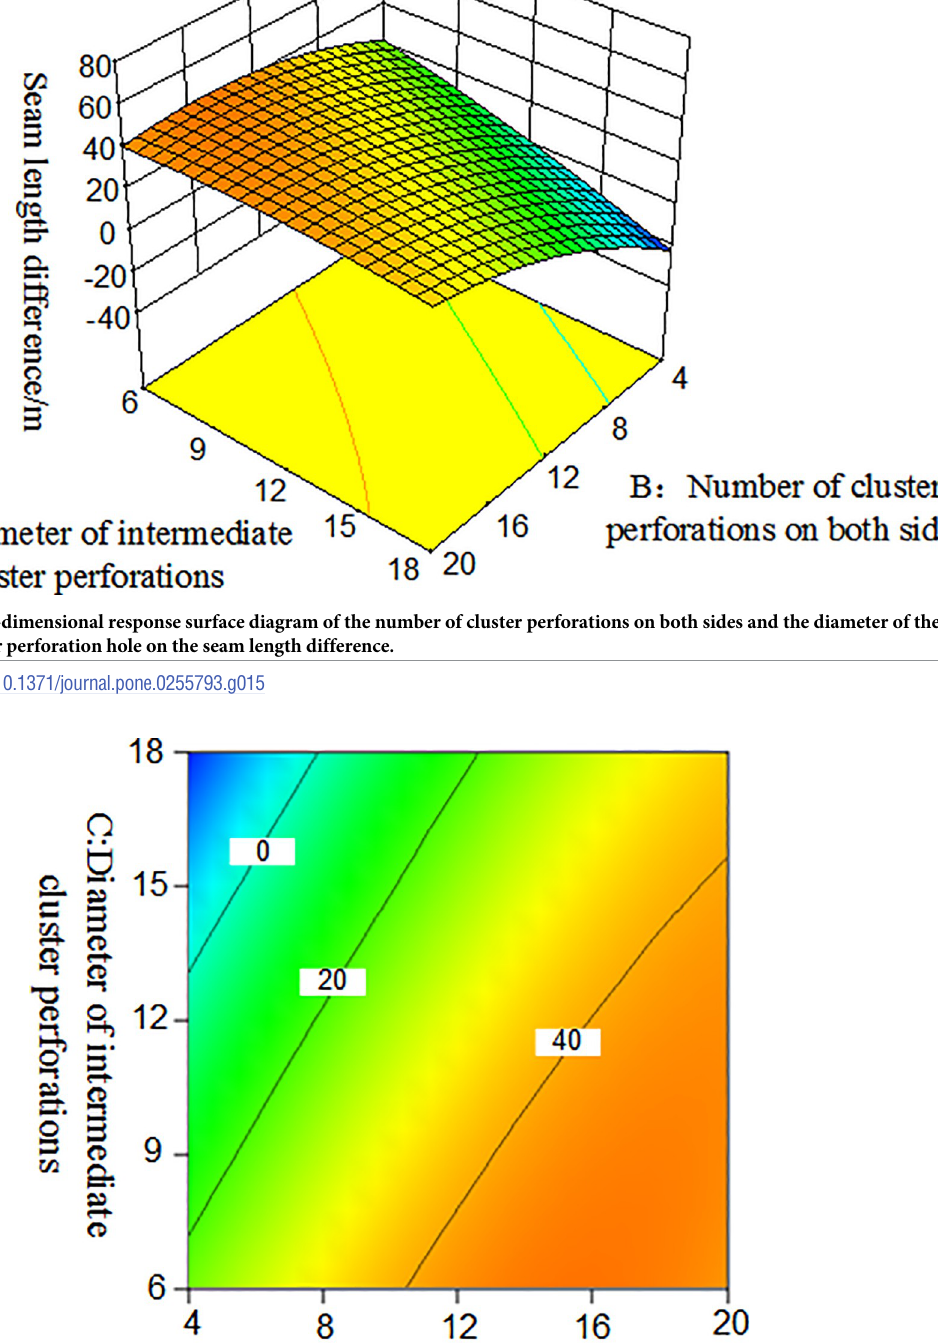
PLOS ONE | https://doi.org/10.1371/journal.pone.0255793 August 18,